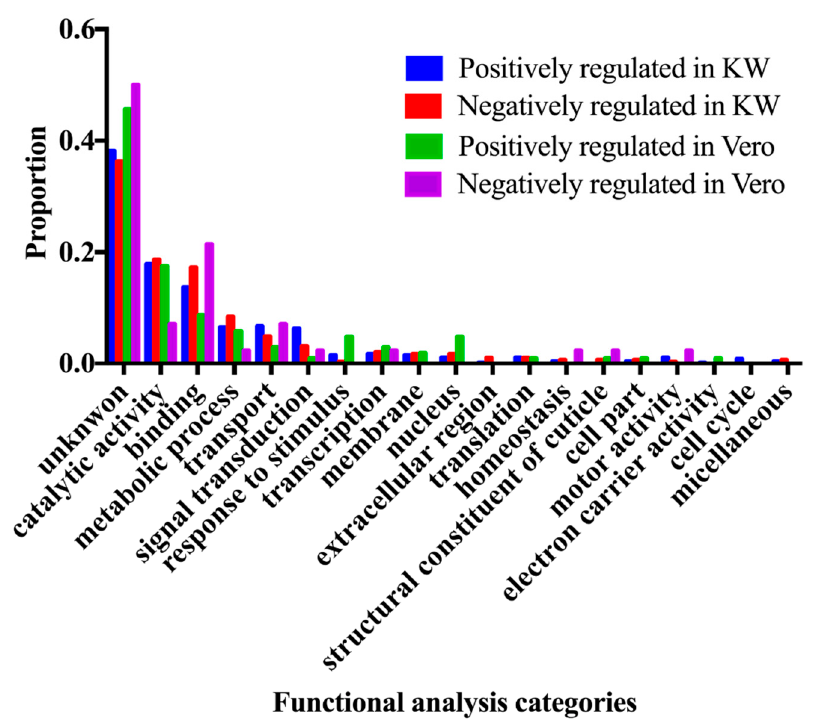
Figure 3. Enriched functional analysis of the regulated expression of the significantly differentially expressed genes ( p < 0.05). Table 1. Infection and dissemination rate results for Chikungunya virus infection in three different populations.